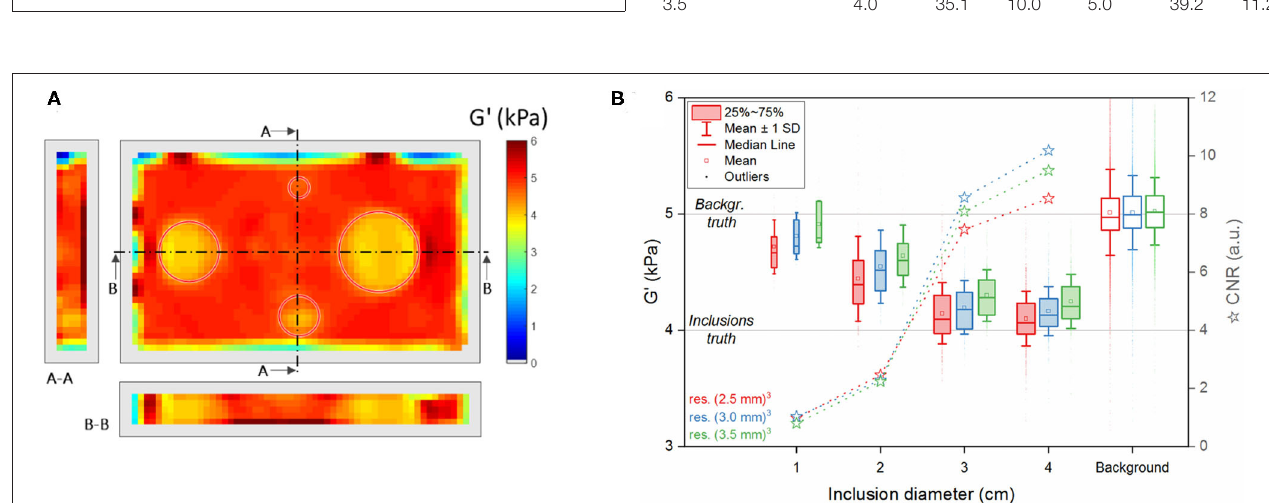
Frontiers in Physics |